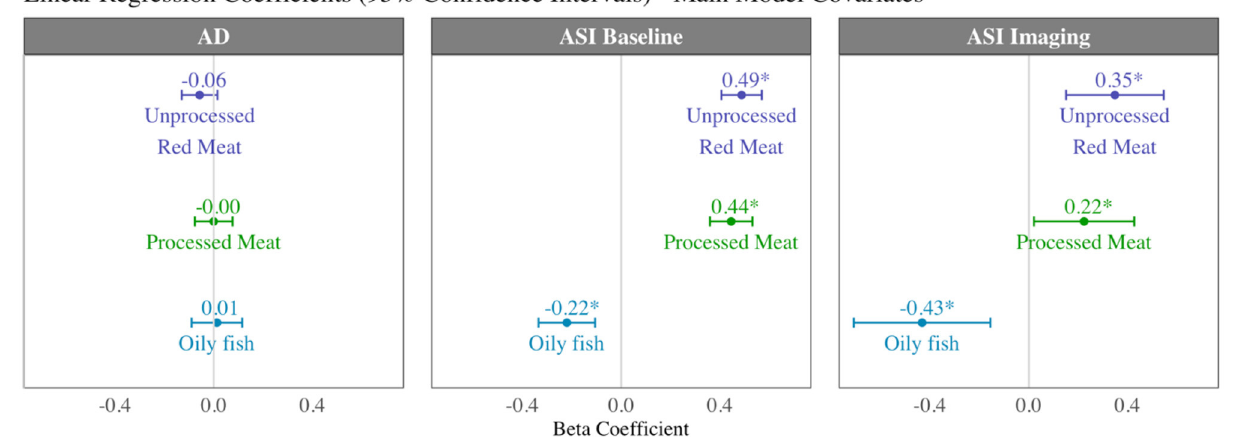
FIGURE 7 | Summary of multivariable linear regression results for arterial compliance measures displaying beta coefficients and 95% confidence intervals per 100g increase in daily intake of meat/fish. Each bar is from a separate model adjusted for age, sex, social deprivation, educational level, smoking, alcohol intake, and exercise level (confounder adjusted model). AD, aortic distensibility; ASI, arterial stiffness